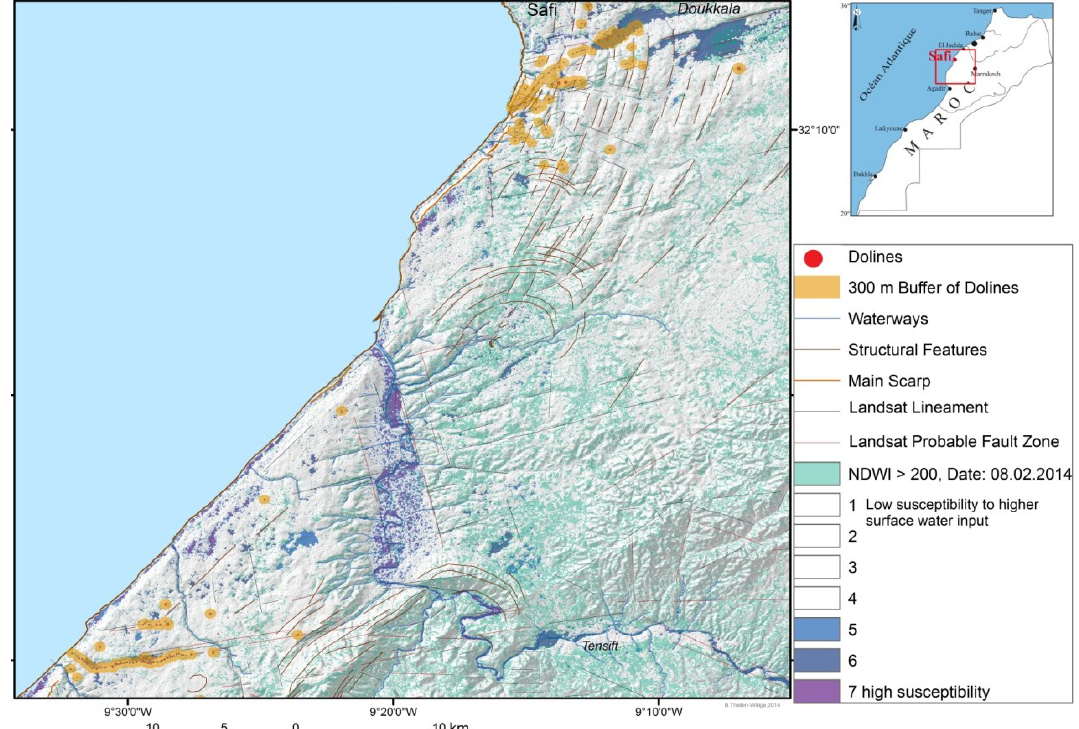
Figure 20. Combination of different approaches and results: merging weighted overlay results with extracted higher Landsat 8- NDWI values and structural